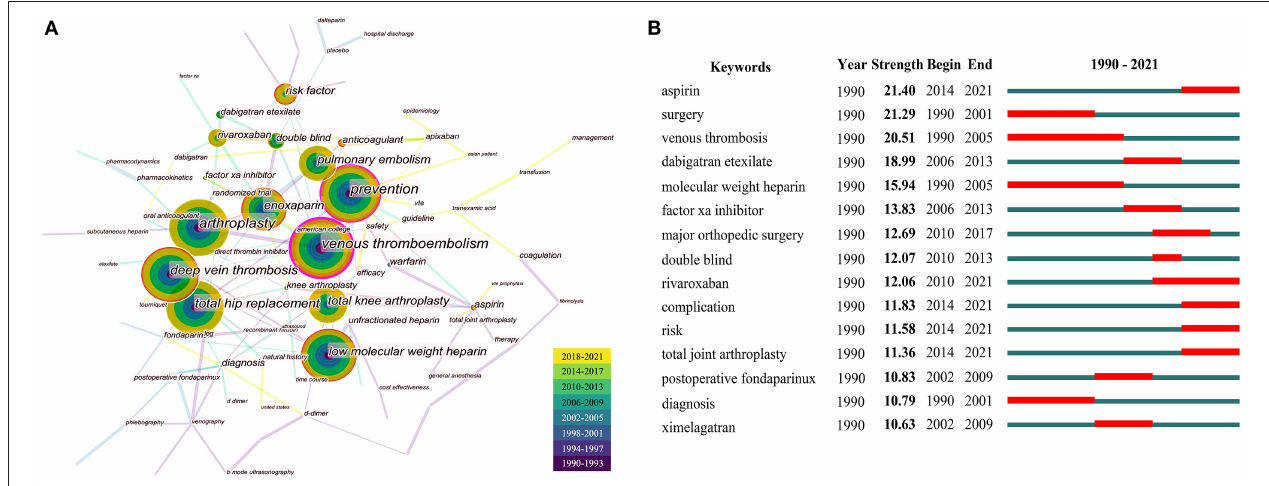
FIGURE 6 | Co-occurrence map of keywords (A) and top 15 keywords with the strongest citation bursts (B) .